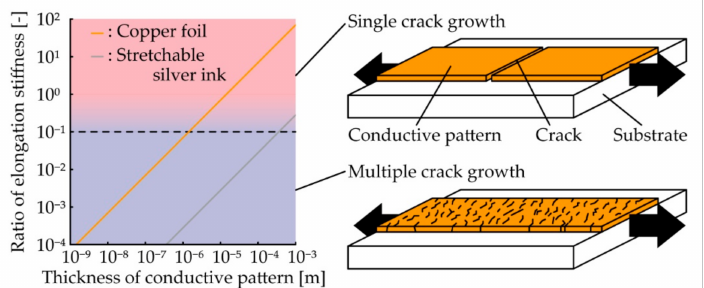
Figure 1. Calculation of the ratio of elongation sti ff nesses of the pattern and substrate plotted against the pattern thickness.